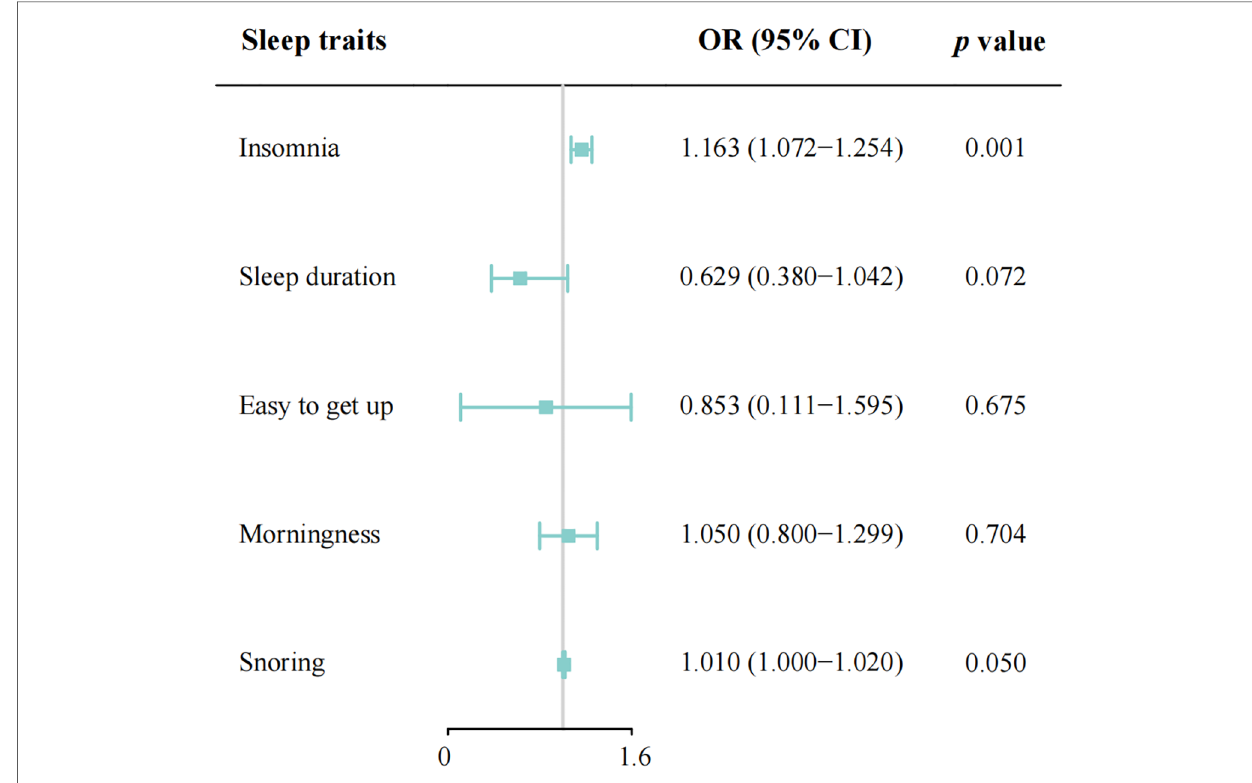
FIGURE 2 Mendelian randomization estimates of genetically predicted sleep disorders on coronary artery disease in patients with diabetes. Easy to get up, ease of getting up in the morning; OR, odds ratio; CI, con fi dence interval; IVW, inverse-variance weighted.